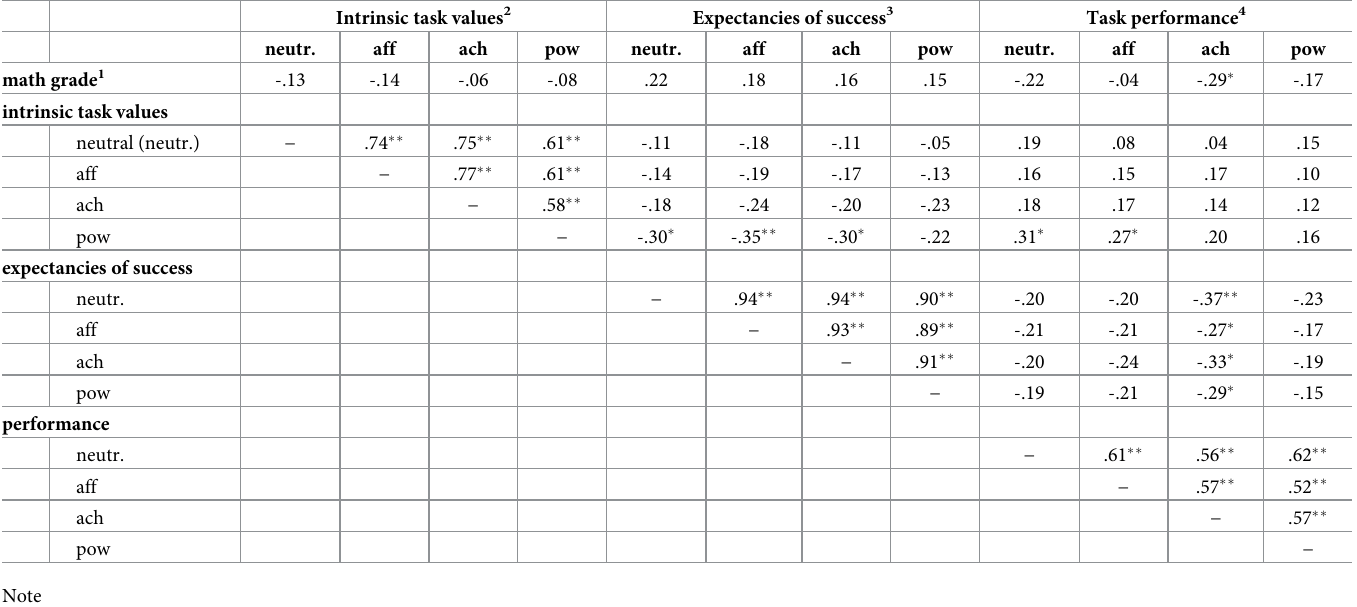
Table 3. Intercorrelations for students’ math grades in high school, intrinsic task values, and expectancies of success and performance in neutral tasks and tasks related to affiliation, achievement, and power in Experiment